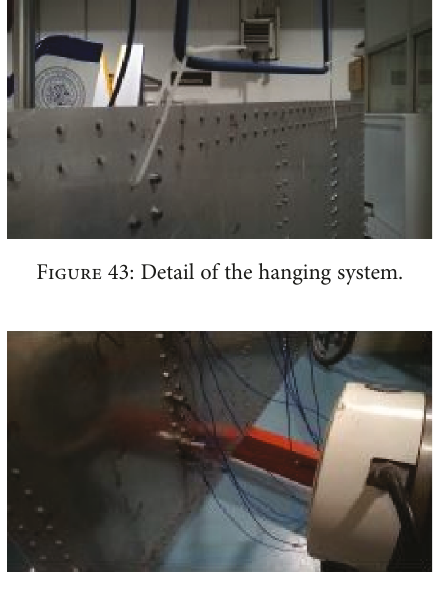
Figure 44: Detail of the rod for panel-shaker connection. Table 5: Load levels used for the sine excitation